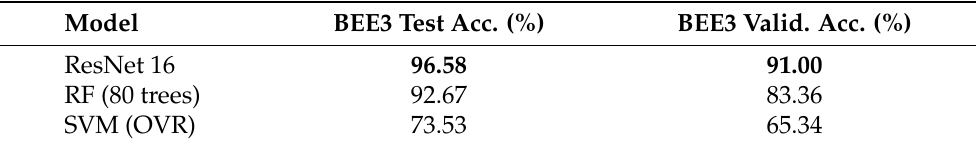
Table 11. Test and validation accuracies of best models of each type on BEE3; best accuracies are in